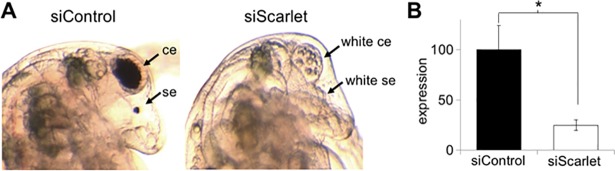
RNA interference of the scarlet ortholog in D. magna.(A) The typical phenotype of embryos injected with the Scarlet-targeting siRNA. The cephalic regions of control siRNA-injected (siControl) and scarlet siRNA-injected (siScarlet) embryos are magnified. The ce and se refer to the compound eye and single eye (ocellus). (B) Gene expression profile of scarlet in embryos injected with Scarlet siRNAs. Error bars indicate the standard error of the mean (n = 3). *P < 0.05 (Student’s t-test).